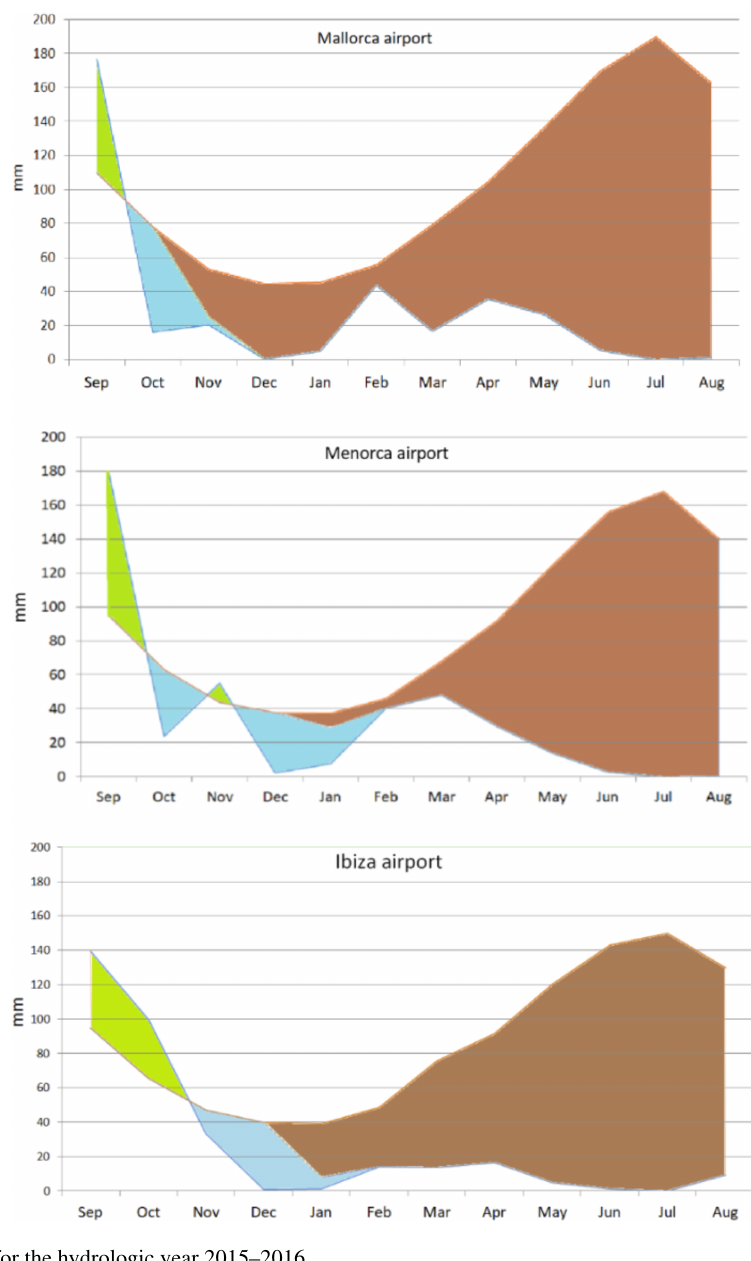
Figure 8. As in Fig. 6 but for the hydrologic year